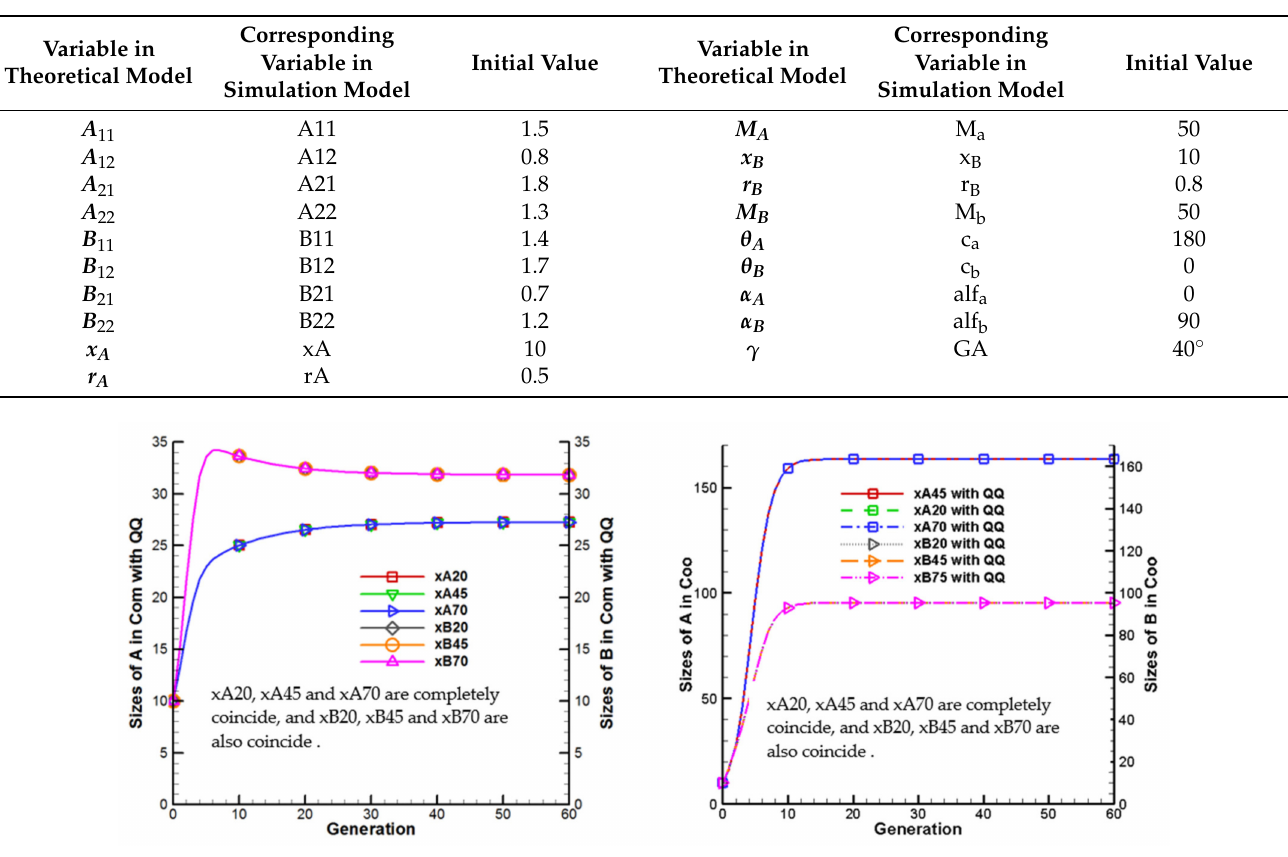
Figure 3. Evolution trajectories for player population sizes in case 1. (Note: QQ is for case 1; 20, 45, and 70 are the different entanglement intensities; Coo and Com are the cooperation and competition coexistence, respectively; xA20 and xB20, xA45 and xB45, and xA70 and xB70 are the evolution trajectories of player A and B population sizes with entanglement intensity 20 ◦ , 45 ◦ and 70 ◦ ,